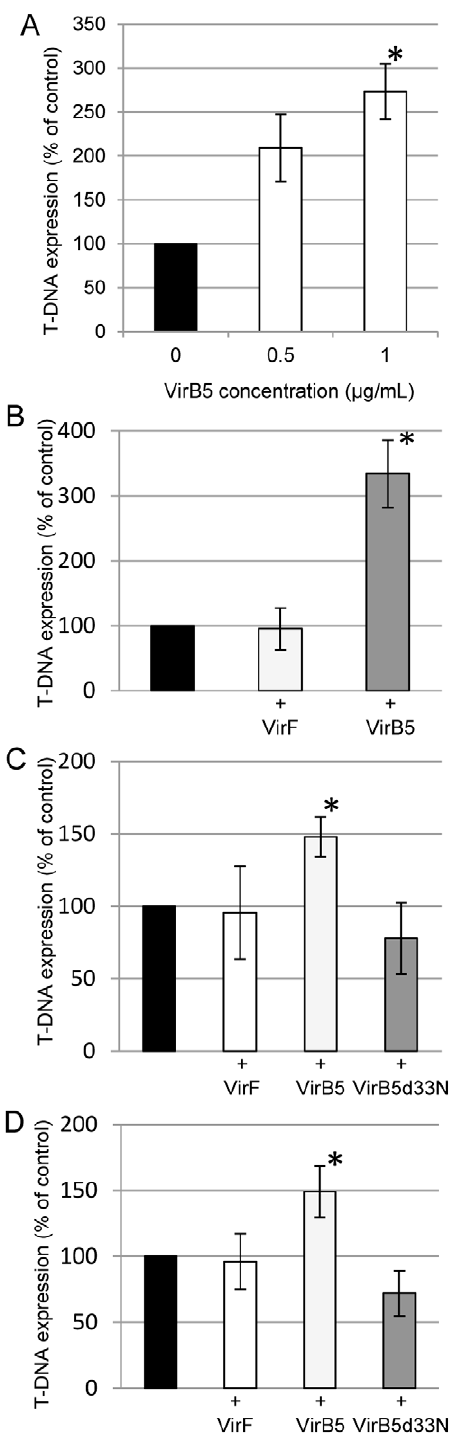
Figure 2. Effect of exogenous VirB5 on transient T-DNA expression. (A) VirB5 concentration effect in agroinfiltrated tobacco leaves. (B) Agroinfiltration of tobacco leaves. (C) Tobacco leaf disc inoculation. (D) Sugar beet hypocotyl segment inoculation. T-DNA control expression levels in the absence of exogenous proteins (black bars) were set at 100%. All data represent average values of three independent experiments with indicated standard deviations. Asterisks indicate a statistical significance ( P -values , 0.01 for panels A and B, and 0.05 for panels C and D) of the difference between experimental and control data.